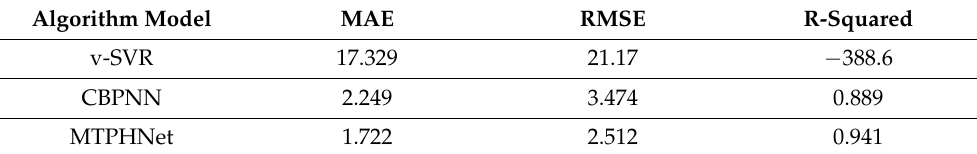
Table 2. Comparison of generalization performance of MTPHNet, v-SVR, and CBPNN. Algorithm Model